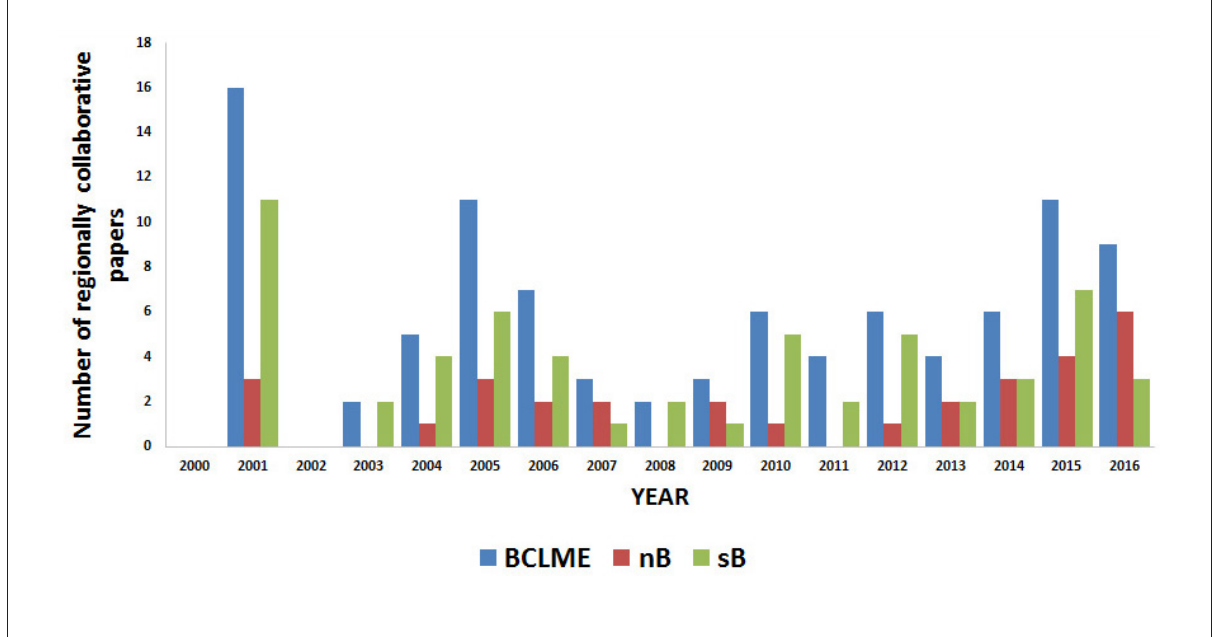
Figure 2: Temporal changes in the numbers of regionally collaborative peer-reviewed journal publications on the resources and/or environment of the Benguela Current Large Marine Ecosystem (BCLME) region over the period 2000–2016, by study focus area: BCLME, regional wide; nB, northern Benguela; sB, southern Benguela.